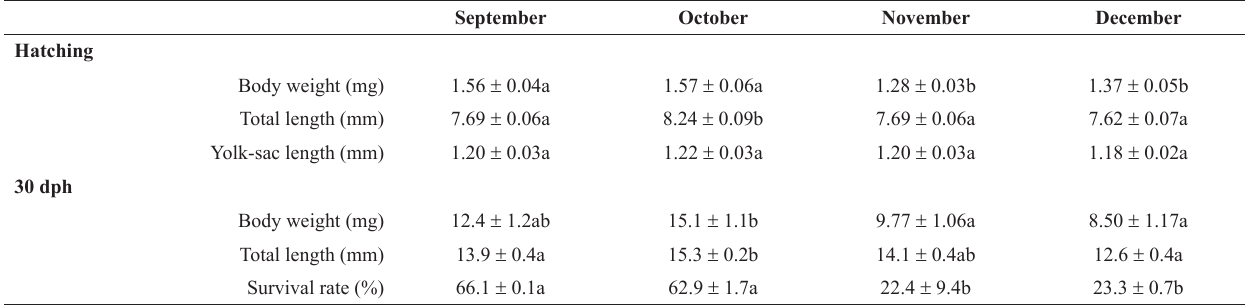
Table 1. Pejerrey larvae measurements at hatching and after 30 dph (mean +SEM). Different letters indicate statistical differences. ANOVA followed by Bonferroni’s multiple comparison tests (n = 30; except for survival rate n = 2; P ≤ 0.05).